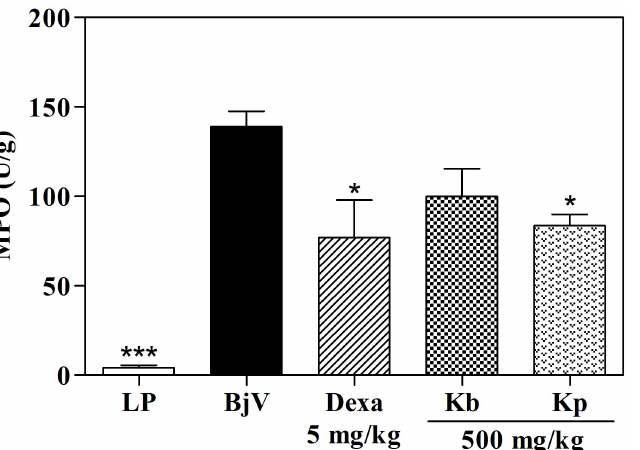
Fig 9. Effect of extractsof K . brasiliensis (Kb) (A) and K . pinnata (Kp) (B) on MPO levels in paw edema induced by B . jararaca venom (BjV) in post-treatment protocol. LP: left paw (basal control; no injectionof venom, extract or dexamethasone). UMPO: a unit of MPO, definedas the equivalent to the consumption of 1 μ mol of hydrogenperoxide per minute. The columns represent the mean ± SEM (n = 5), * p < 0.05compared to the control group (i.pl. injectionof BjV with i.p. administration of 5% castor oil in PBS) (one-way ANOVA followedby the Tukey’s